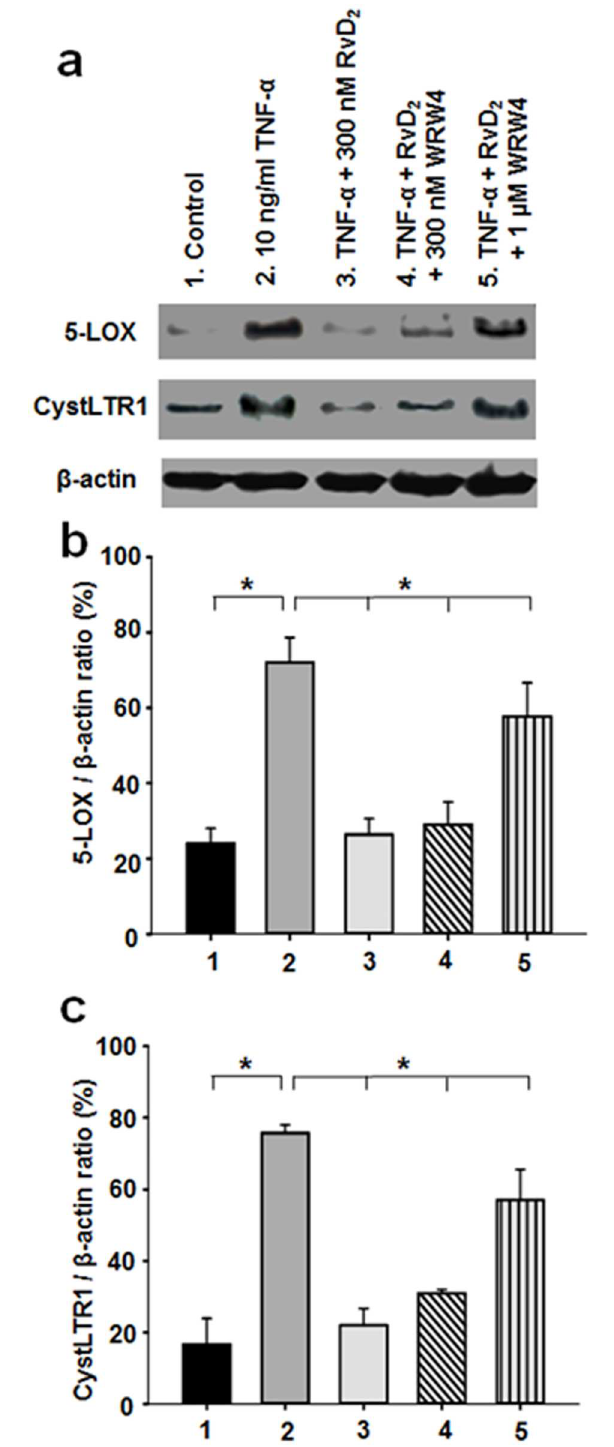
Fig 4. Effect of RvD 2 and WRW4 treatments on 5-LOX and CysLTR1 expressionin TNF- α -pre-treated human bronchi. a. Western blot analysesof bronchial homogenates derived from control, TNF- α , TNF- α +